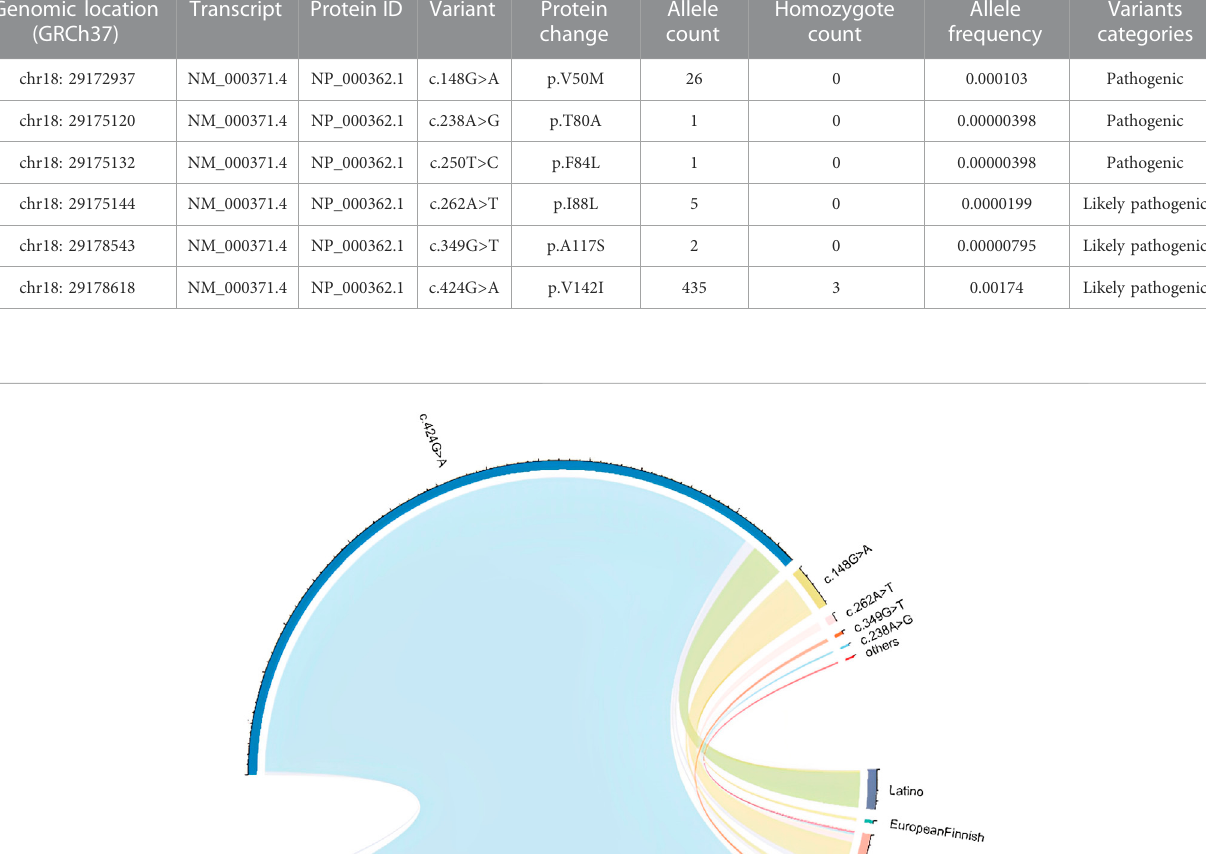
TABLE 1 Variants in the TTR gene classi fi ed as disease-causing variants from the gnomAD database global population. Genomic location (GRCh37)